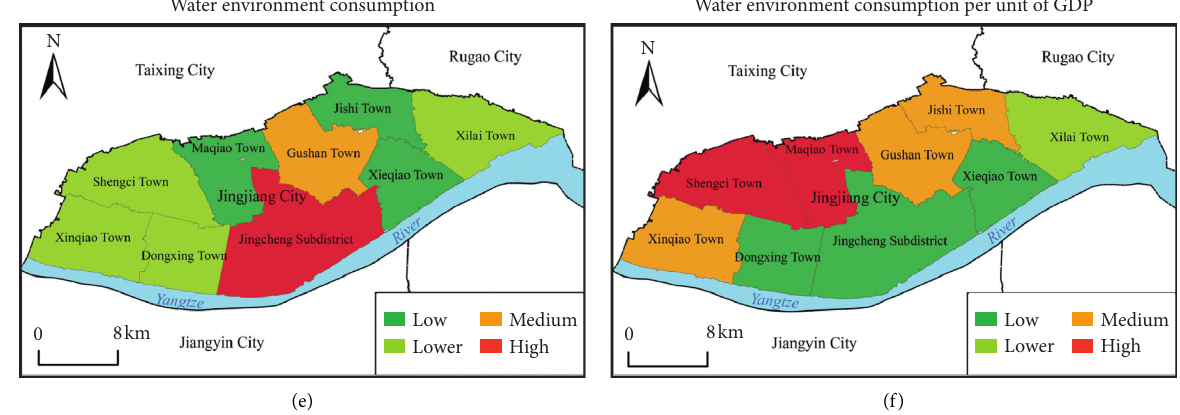
Figure 2: Resource and environment consumption and the resource and environment consumption per unit of GDP for each